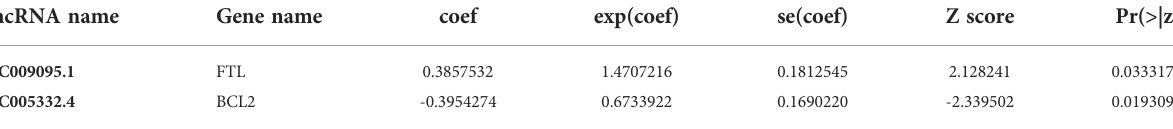
TABLE 2 The results of lncRNAs on account of TCGA CESC data after the multivariate Cox regression. lncRNA